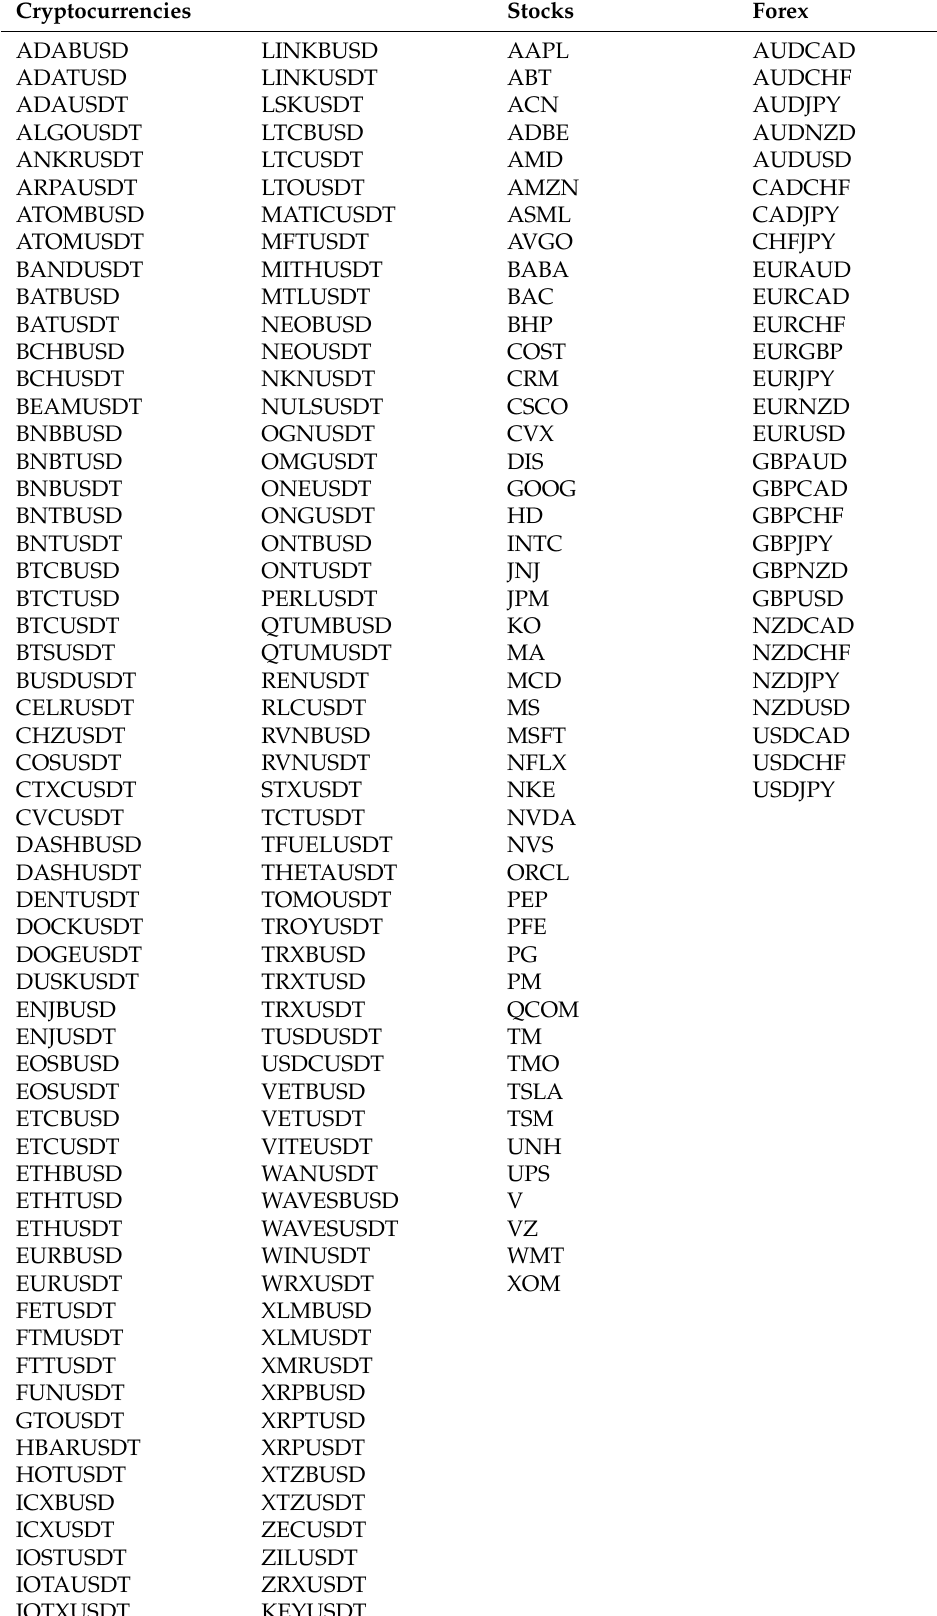
Table 3. List of assets used on each